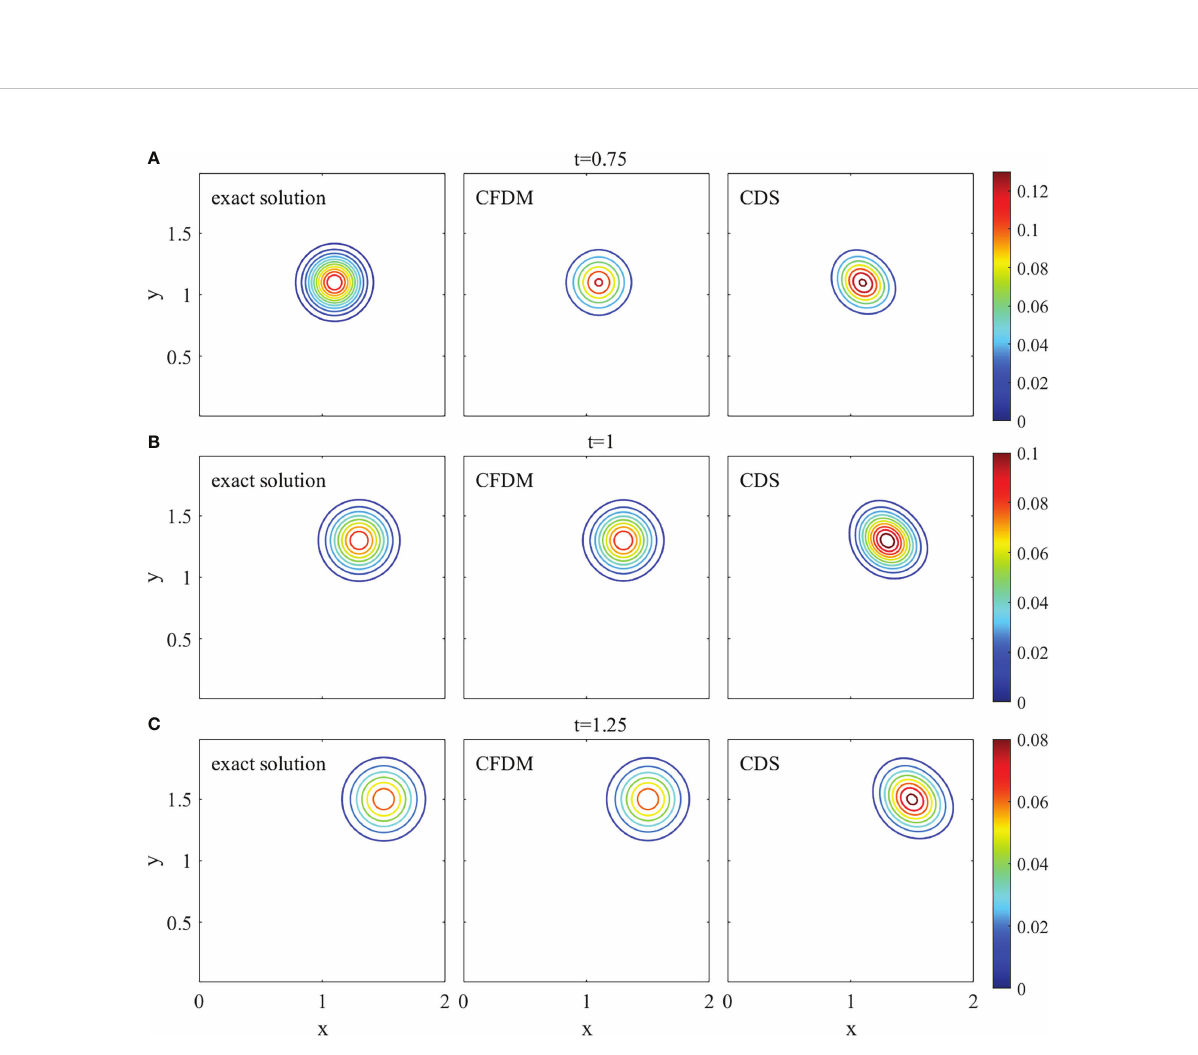
FIGURE 3 The contour plots of the 3D Gaussian hump at z = 0.6 with different times (A) t=0.75, (B) t=1, (C) t=1.25.